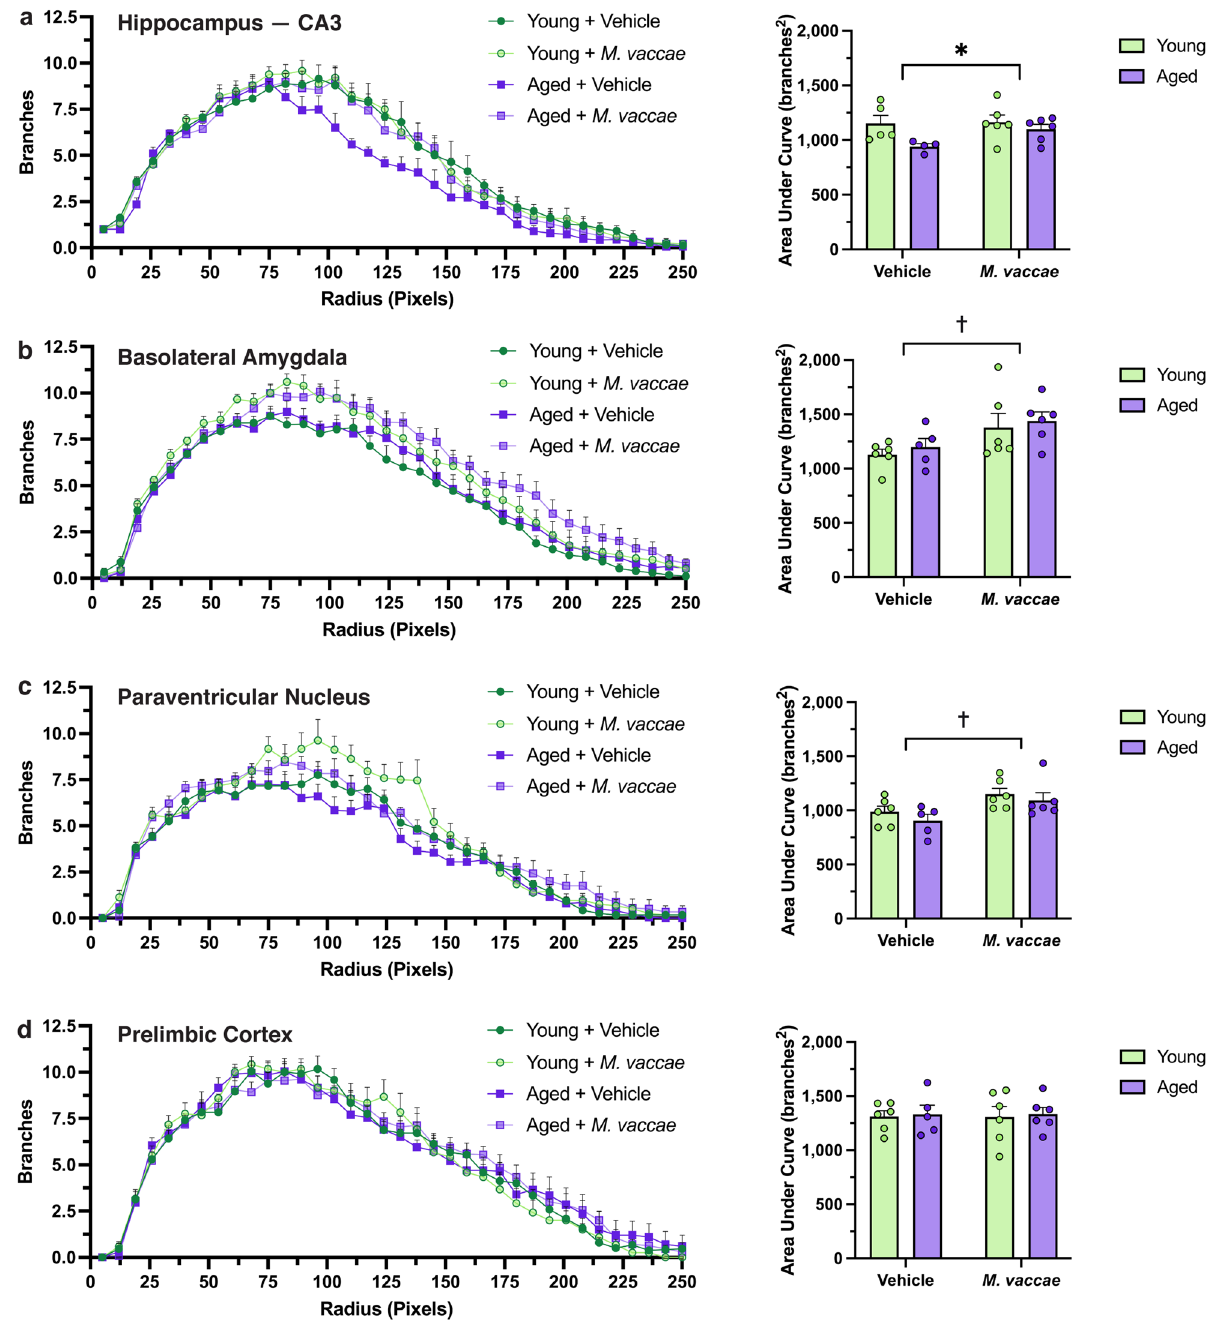
Figure 4. M. vaccae immunization leads to elevated overall branching independent of age in the basolateral amygdala and paraventricular nucleus. ( a – d ) Plotting branches vs. radius from soma reveals differential changes in microglial branching due to age and M. vaccae immunization. Global differences in microglial complexity were assessed with an area under the curve analysis. The data are graphed as mean ± SEM; n = 4–6 rats/group (3–5 microglia/rat); * p < 0.05, main effect of age; † p < 0.05, main effect of M. vaccae